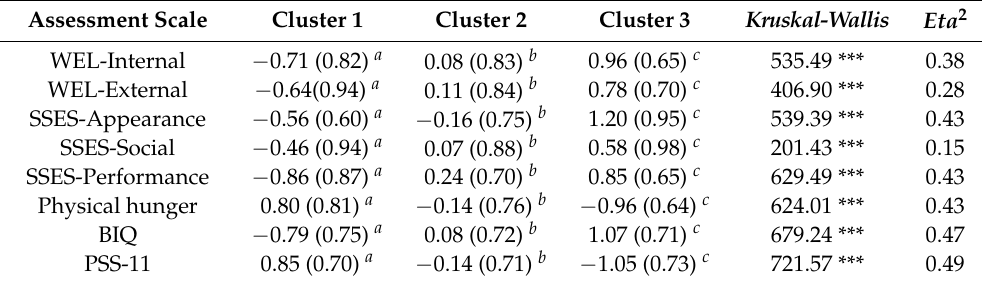
Table 3. Mean comparisons on the standardized clustering variables used in the female subsample.